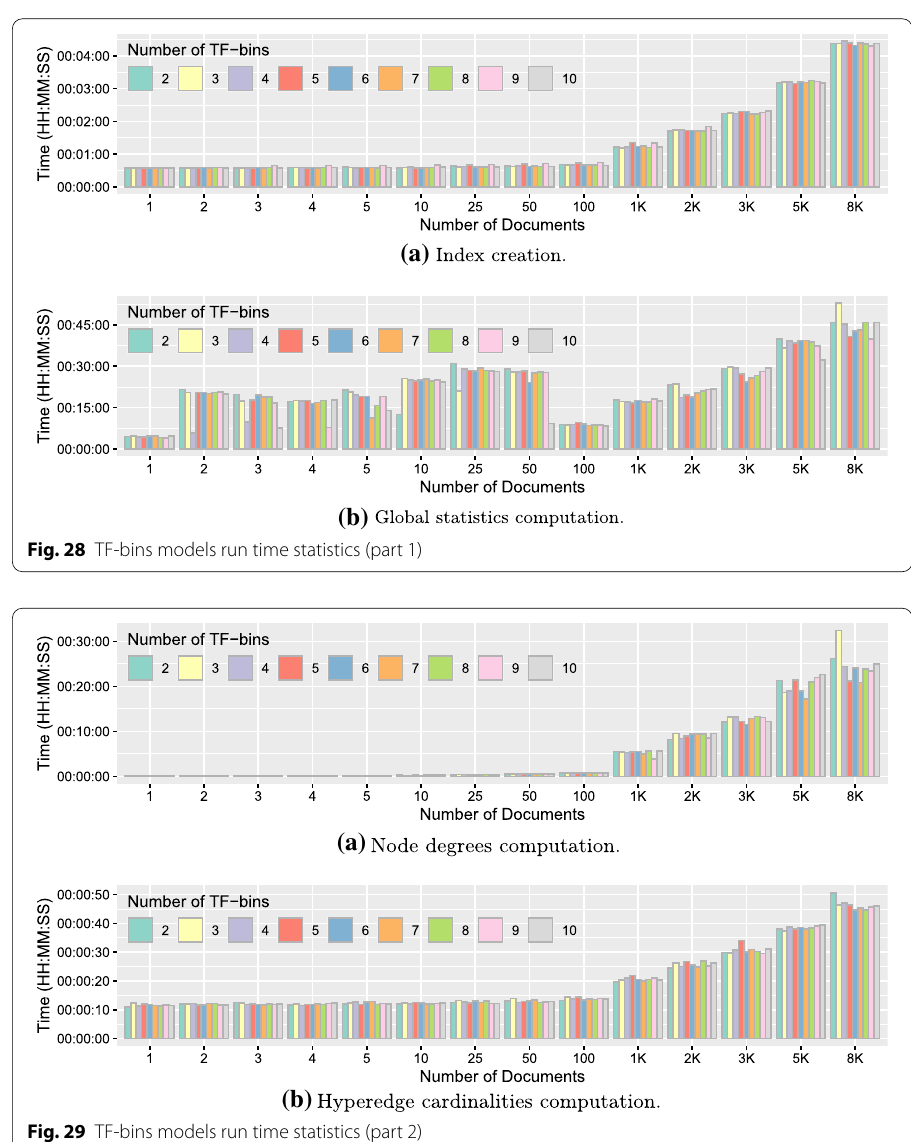
Fig. 29 TF-bins models run time statistics (part 2)